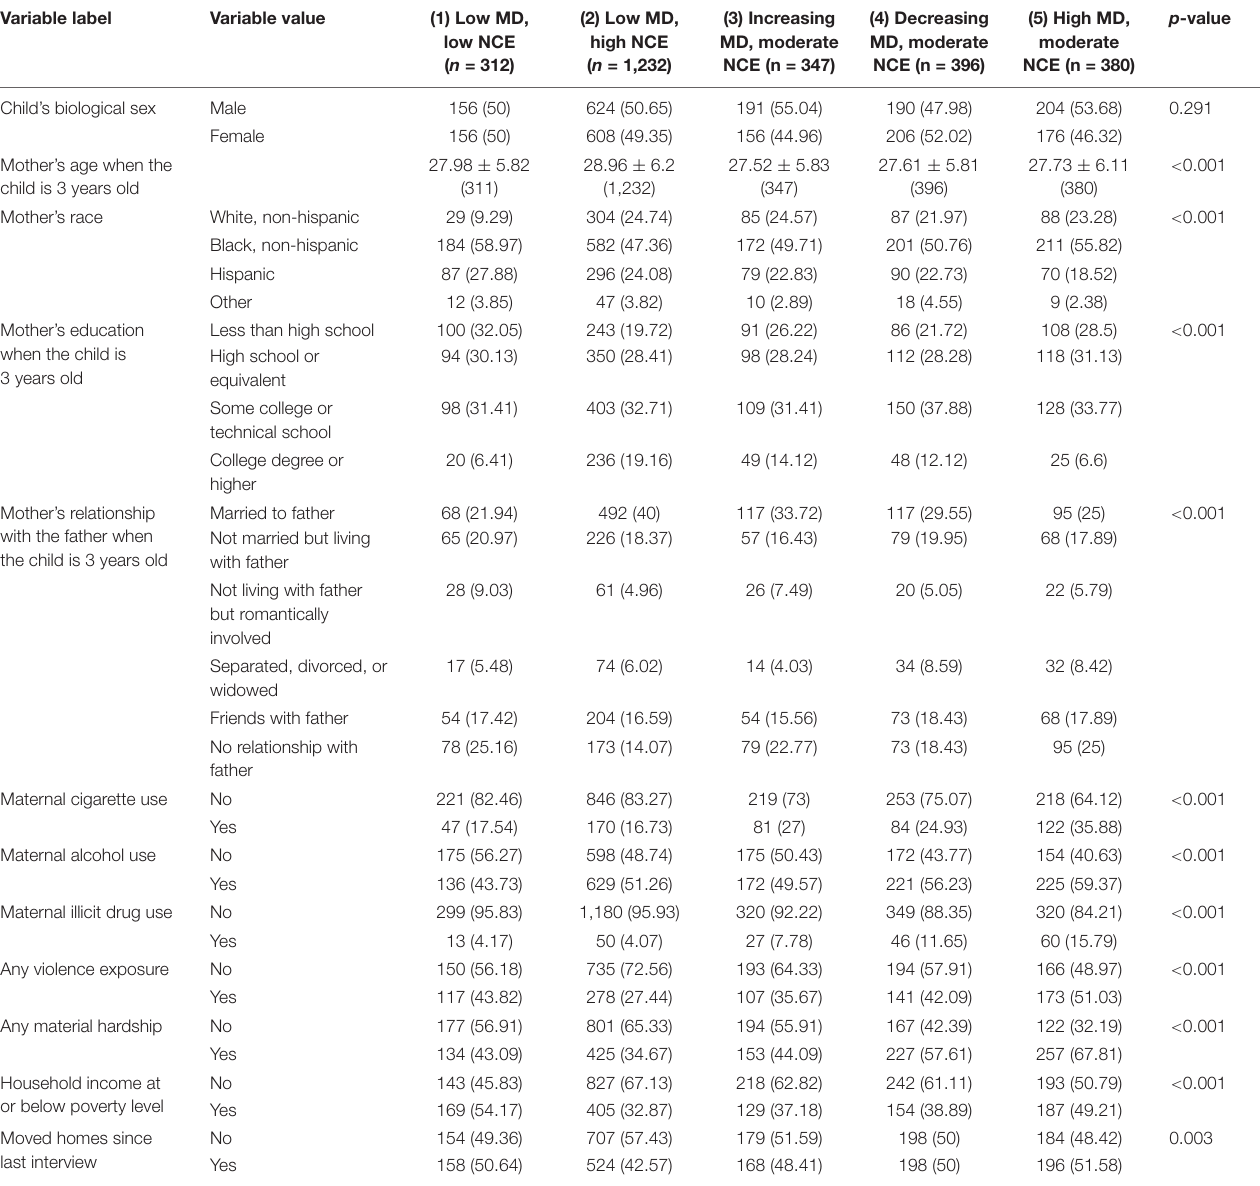
TABLE 2 | Baseline (child’s age 3) sociodemographic and risk characteristics of mothers and children in each trajectory group. Variable